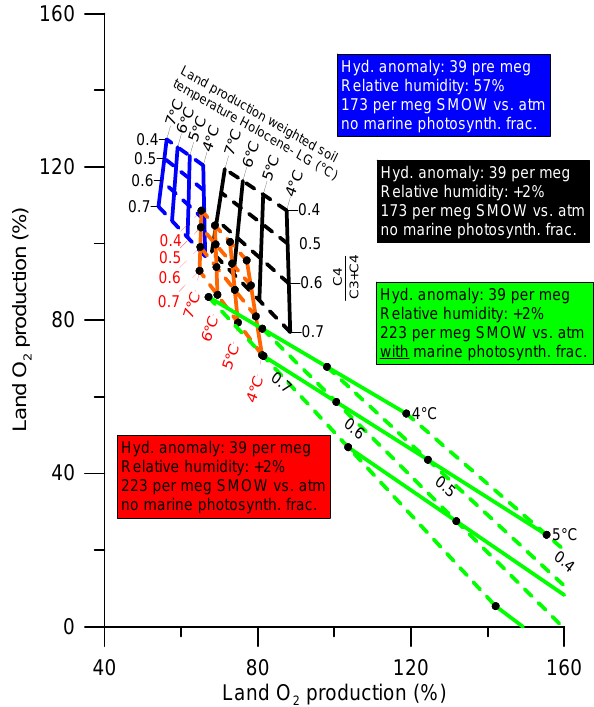
Fig. A4 Effect of initializing the calculations with a 17 1 modern ocean water vs. modern atmosphere of 173 and 223 per meg, respectively (Barkan and Luz, 2011), and allowing fractionation during marine photosynthesis (Luz and Barkan, 2011) for a LGM situation (Table 4). In blue the standard case with 173 per meg modern ocean water vs. modern atmosphere. For all other calculations the relative humidity was increased by 2% with respect to the initialization value. The calculations were made with 173 per meg modern ocean water vs. modern atmosphere in black, and 223 per meg in red and green. Marine photosynthetic fractionation was set to 4‰ in δ 18 O ( λ of 0.524) for the green case